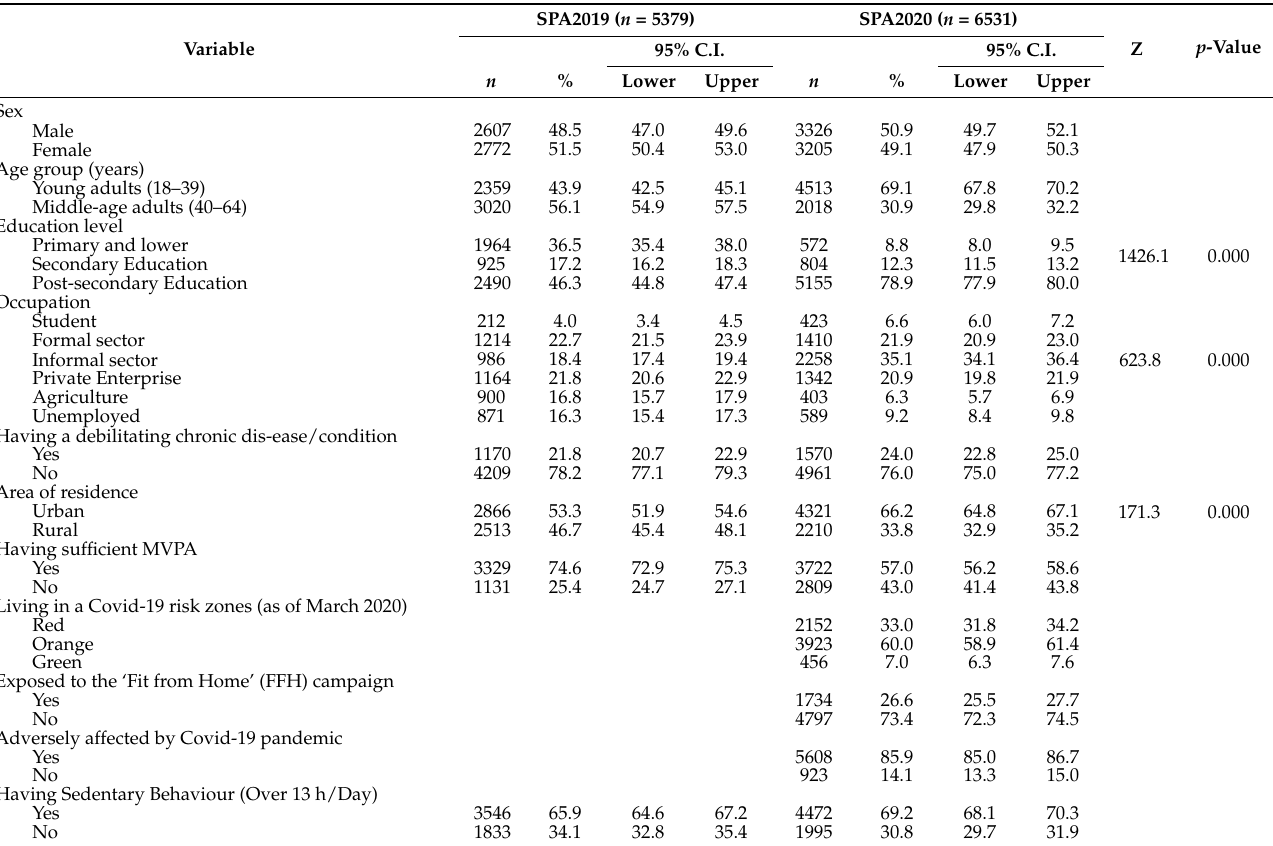
Table 1. Socio-demographic characteristics of survey